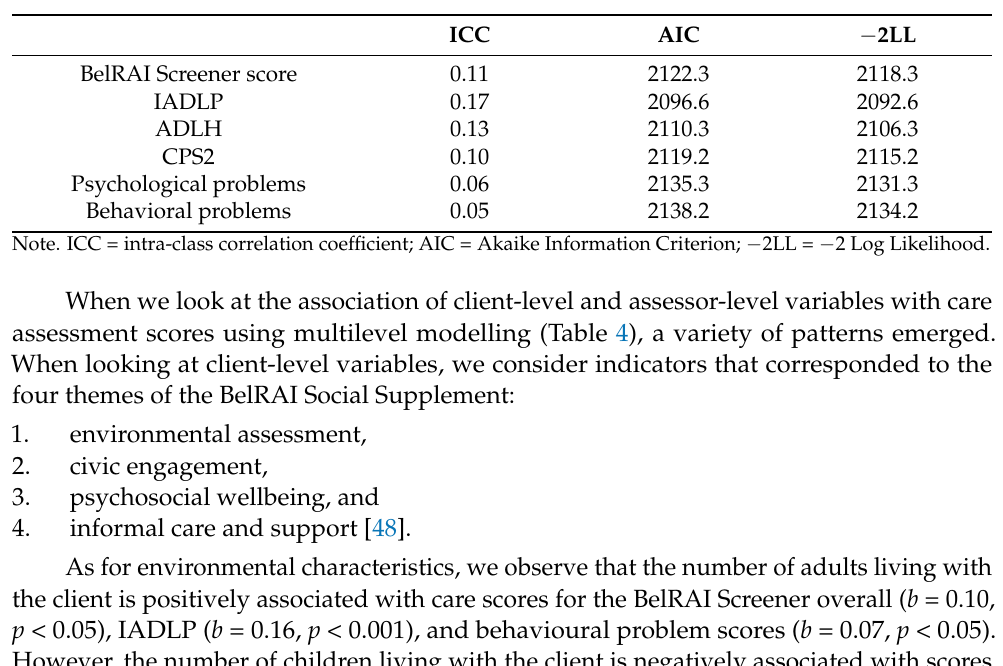
Table 3. Intra-class correlation coefficients of dependent variables in null